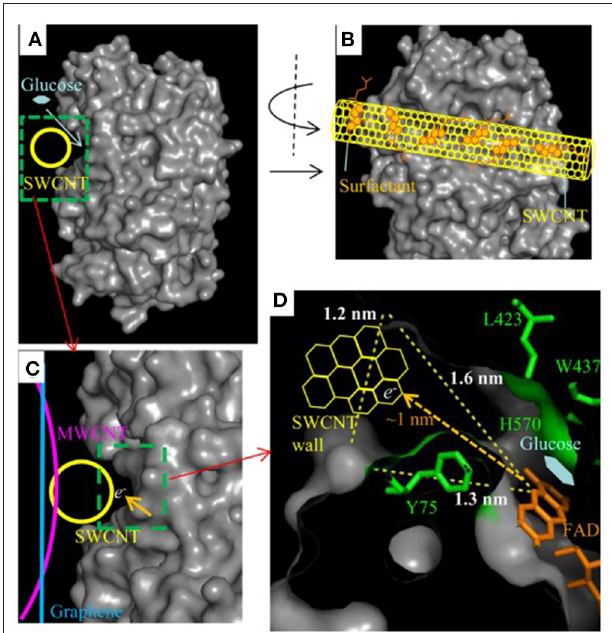
FIGURE 1 | Schematic of possible DET route between FAD-GDH and debundled SWNT. (A) and (B) show possible location of debundled SWNT in the indentation of FAD-GDH; (C) compares the locations of MWNT, graphene, and debundled SWNT with respect to the FAD-GDH; (D) visualizes the reduced distance for electrons to travel from the FAD cofactor to the debundled SWNT ( Muguruma et al.,